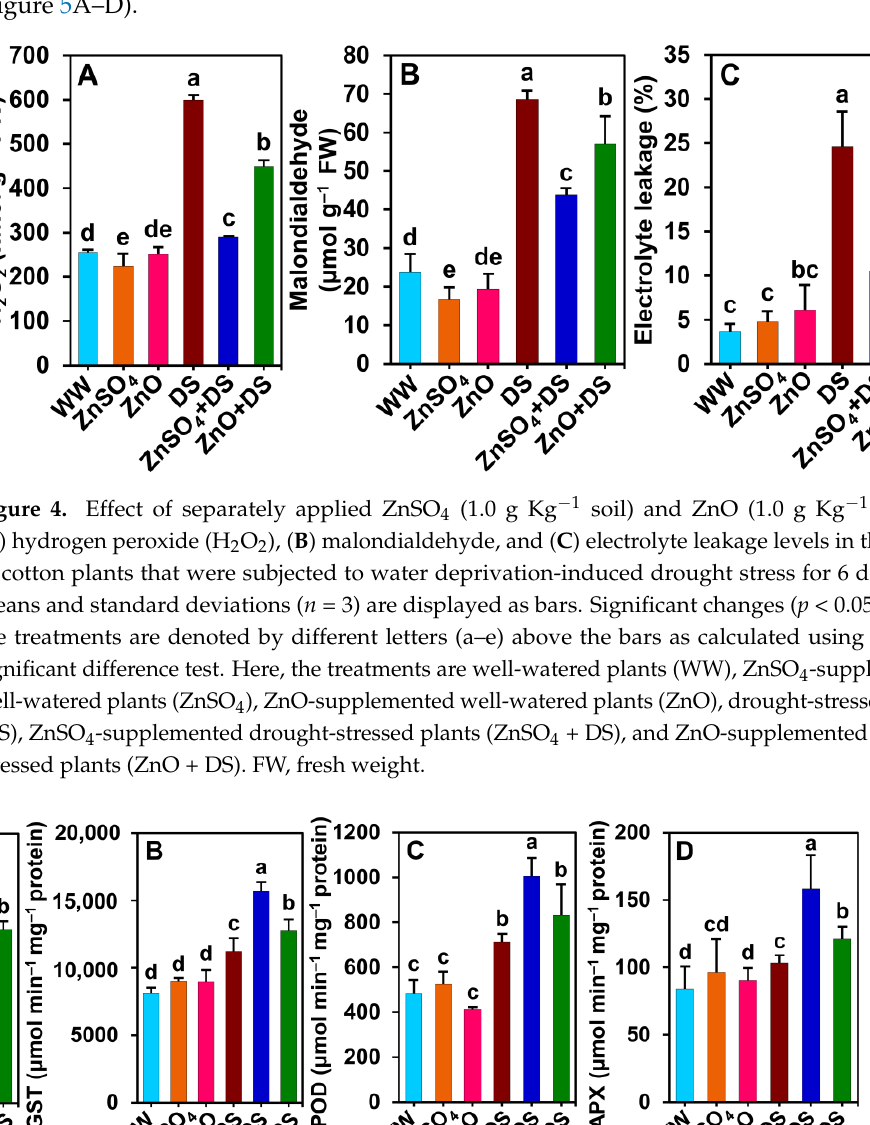
Figure 4. Effect of separately applied ZnSO 4 (1.0 g Kg −1 soil) and ZnO (1.0 g Kg −1 soil) on ( A ) hydro- gen peroxide (H 2 O 2 ), ( B ) malondialdehyde, and ( C ) electrolyte leakage levels in the leaves of cotton plants that were subjected to water deprivation-induced drought stress for 6 days. The means and standard deviations ( n = 3) are displayed as bars. Significant changes ( p < 0.05) among the treatments are denoted by different letters (a – e) above the bars as calculated using the least significant differ- ence test. Here, the treatments are well-watered plants (WW), ZnSO 4 -supplemented well-watered plants (ZnSO 4 ), ZnO-supplemented well-watered plants (ZnO), drought-stressed plants (DS), ZnSO 4 -supplemented drought-stressed plants (ZnSO 4 + DS), and ZnO-supplemented drought- stressed plants (ZnO + DS). FW, fresh weight.